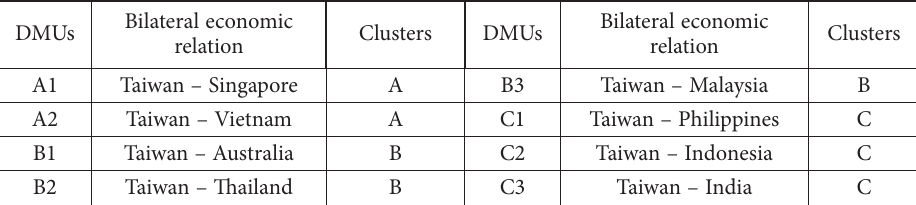
Table 1. List of eight bilateral economies (source: compiled by the author)